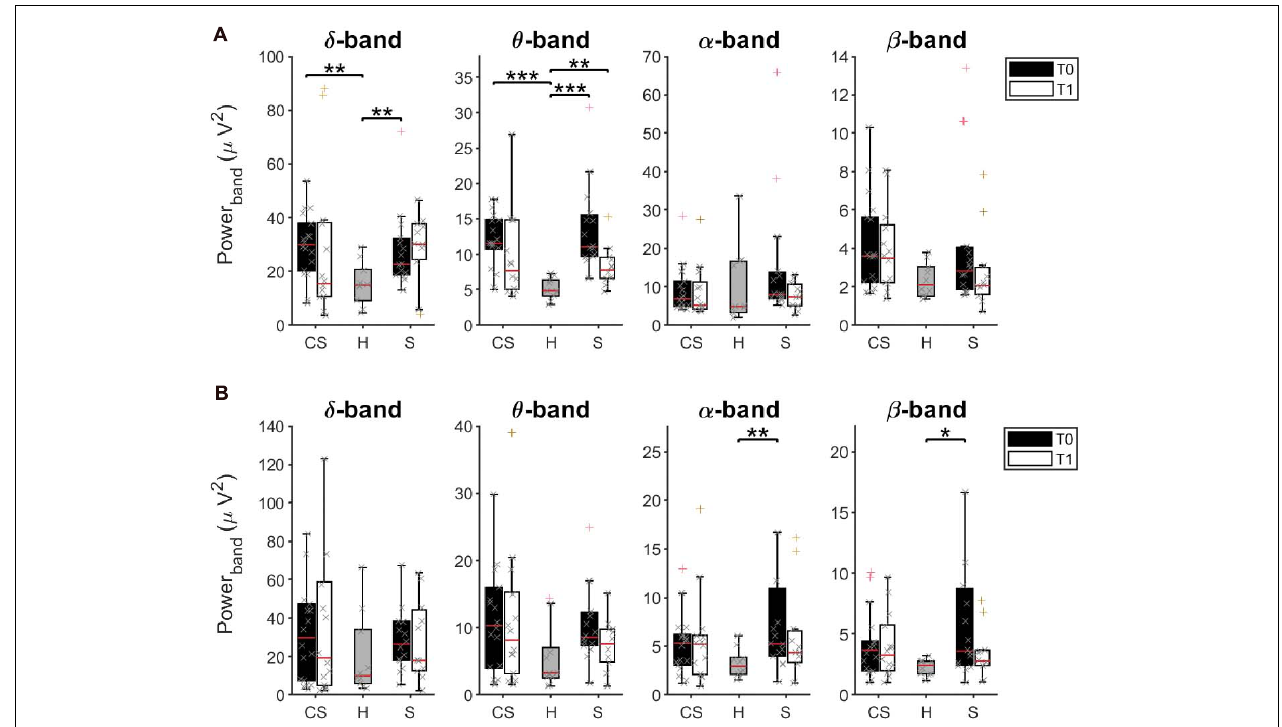
FIGURE 2 | Average Power Spectral Density of EEG sensors (A) and of reconstructed ROIs (B) in δ , θ , α , and β bands at T0 and T1, respectively, for cortico-subcortical ( CS ) patients, subcortical ( S ) patients and healthy subjects ( H ). * p < 0.05, ** p < 0.01, *** p < 0.001.